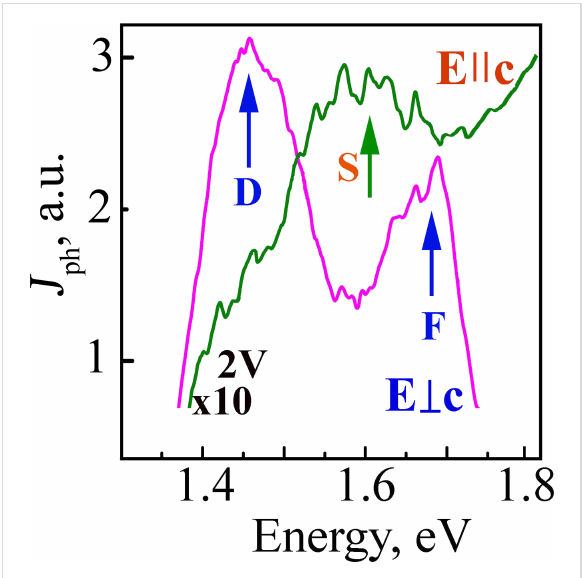
Figure 4: The photoconductivity spectra registered when 2 V is applied to the In–Sb 2 Se 3 contacts (Figure 3A, insert) under the E|| c and E ⟂ c polarization conditions.